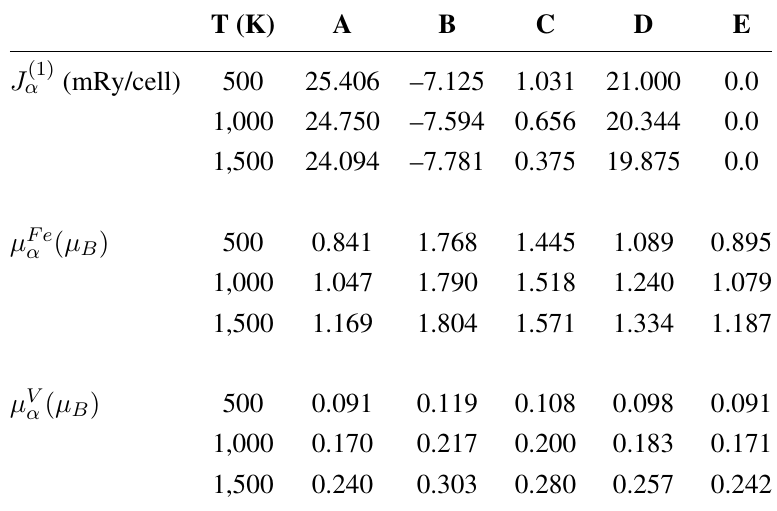
Table 4. On-site parameters J (1) (mRy/cell) and local magnetic moments of Fe and V atom α µ Fe and µ V calculated for the lattice parameters V = 0.38319 nm 3 and c/a = 0.517 α α